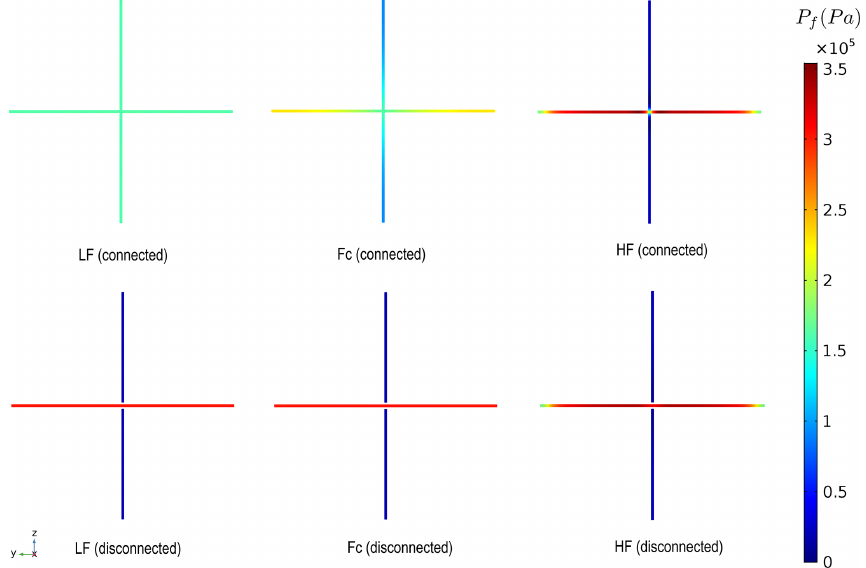
Figure 3. Snapshots of the fluid pressure P f in the cracks at three different frequencies: LF – the low-frequency limit (corresponds to 10 1 Hz, relaxed state), Fc – intermediate frequency snapshot (corresponds to 10 4 Hz, close to the characteristic frequency) and HF – the high-frequency limit (corresponds to 10 6 . 5 Hz, unrelaxed